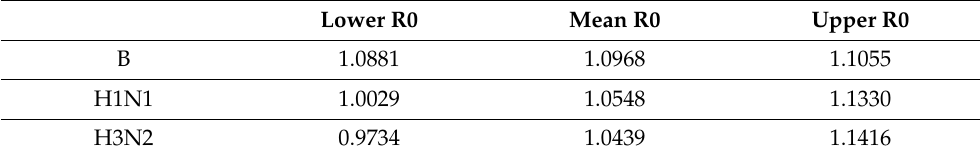
Table A10. Lower and upper bounds for R0 (QIVe).